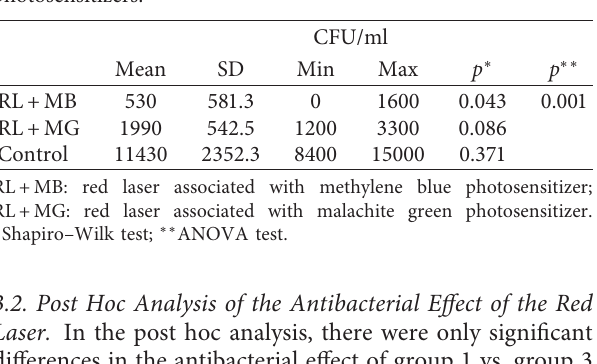
Table 1: Comparison of the antibacterial effect of the red laser on premolars contaminated with E. faecalis using different